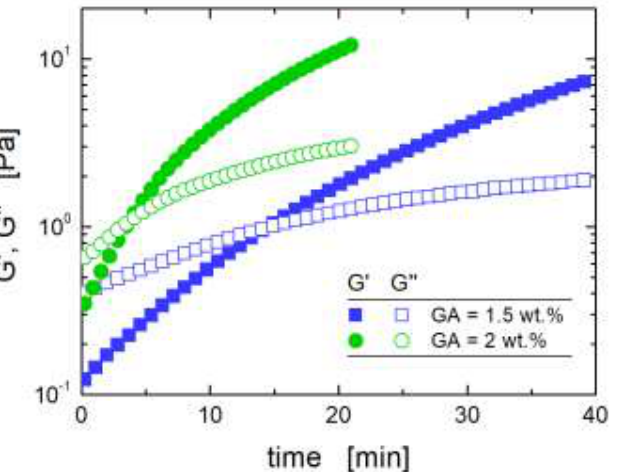
Figure 2. Time dependence of the elastic (full symbols) and loss (empty symbols) modulus at a frequency of 1 rad s −1 for aqueous CS/LTA (weight ratio equal to 2:1) dispersions crosslinked at 25 °C with 2 (circles) and 1.5 (squares) wt.% of GA.